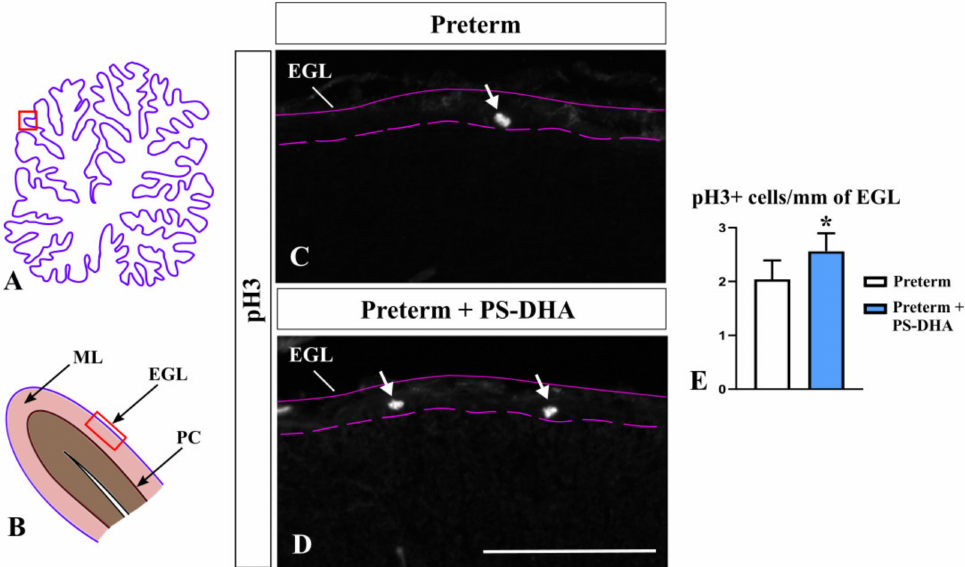
Figure 2. PS-DHA increases mitotic (pH3 + ) granule precursors in the preterm pig cerebellum. ( A , B ) Schematic of midsagittal section of the newborn pig cerebellum ( A ). Panel B shows a higher magnification of the region boxed in panel A. EGL, external granule cell layer, ML, molecular layer, PC, Purkinje cell layer. Panels C and D display sections immunostained against pH3, photographed under 10 × magnification, which correspond to the region shown by the box in panel B. ( C – E ) Arrows point to mitotic (pH3 + ) granule precursors in the EGL ( C , D ), which were increased in preterm pigs that received PS-DHA relative to control group of preterm pigs ( E ). n = 5 pigs per group, * p < 0.05. Pink solid and dashed lines show the outer and inner boundaries of the EGL, respectively. Scale bar: 100 µ